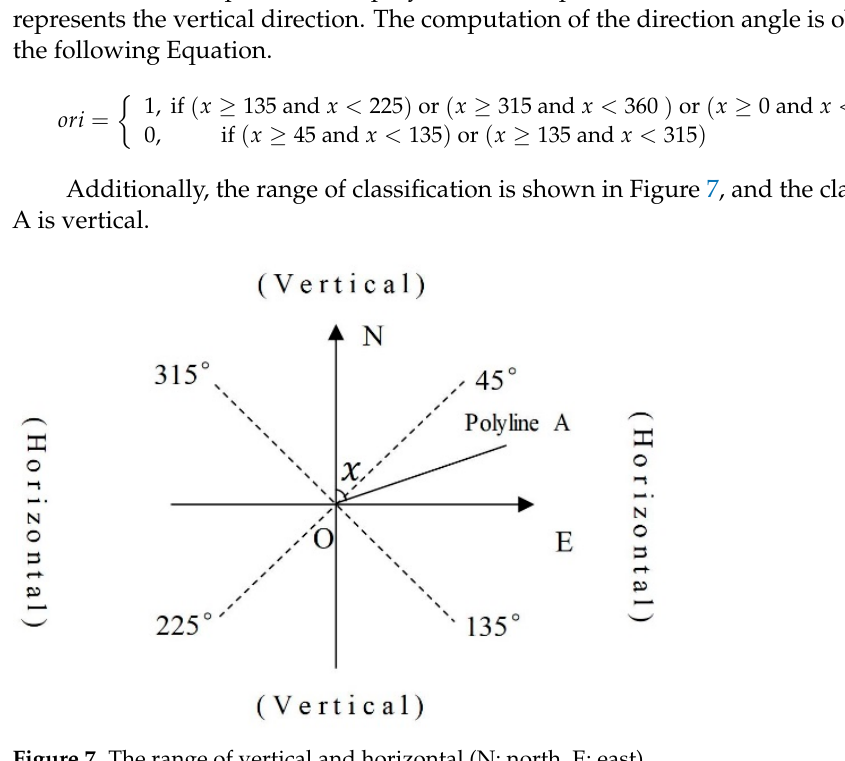
Figure 6. Computation of minimum distance.